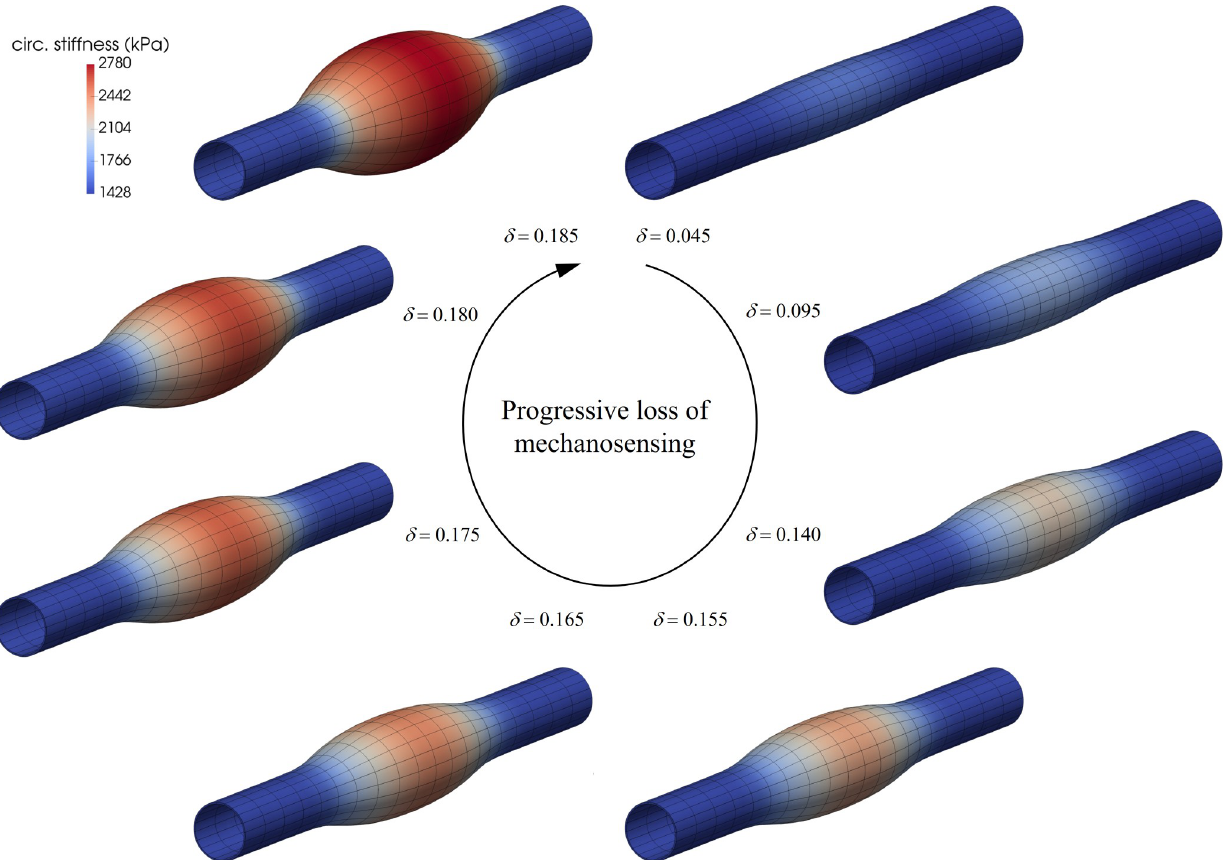
Fig 3. Mechanobiologically (quasi)equilibrated, progressive dilatation of an initial non-aneurysmal aortic segment with increasingly greater losses of mechanosensing δ > 0 (clockwise from the upper right mesh). Note that the dilatation tended to asymptotic for δ ! 0.185 + , suggesting the presence of a mechanobiological static instability [33] while maintaining inner pressure P = P . Indeed, equilibrium solutions for δ � 0.185 + could not be achieved using h o standard Newton-Raphson global finite element iterations (hence defining the severe case in Figs 1 and 2 at δ = 0.185), suggesting the need for path- following (e.g., arc-length) methods to better capture numerically, and advance quasi-statically, these nearly-singular unstable